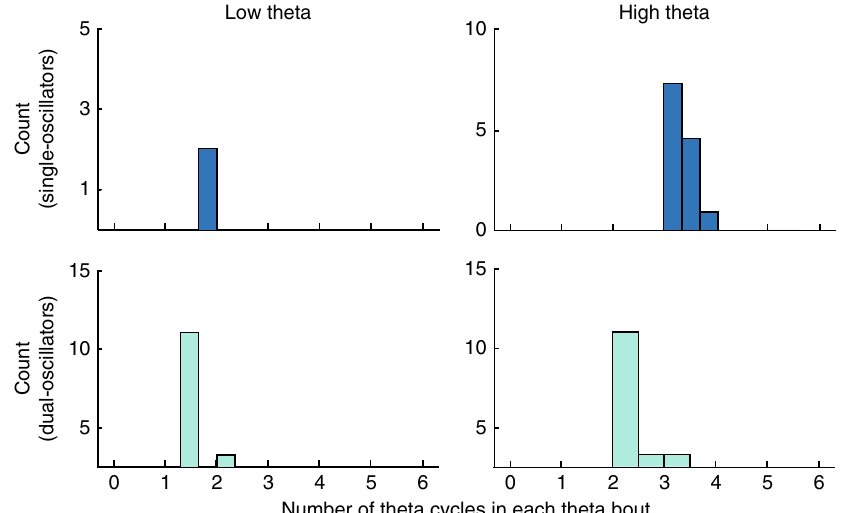
Fig. 4 Number of theta cycles within individual theta oscillation bouts. Histograms showing the distributions of mean cycle lengths of the bouts of theta oscillations from individual electrodes. Individual plots show these distributions separately for low- and high-theta oscillations from single- and dual- oscillator (Fig. 4). Here, prior to statistical analysis, we fi rst averaged oscil- electrodes in a subject (see Methods).